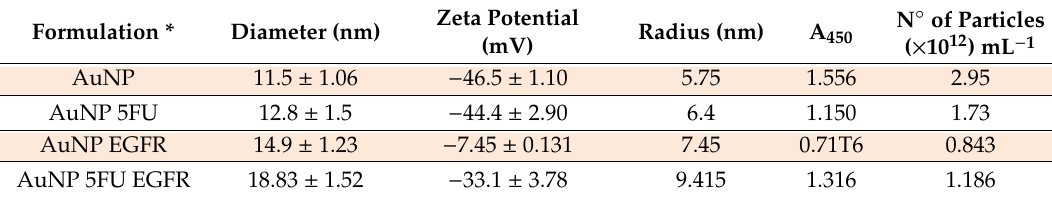
Table 1. Physicochemical characterization of AuNP and their constructs.